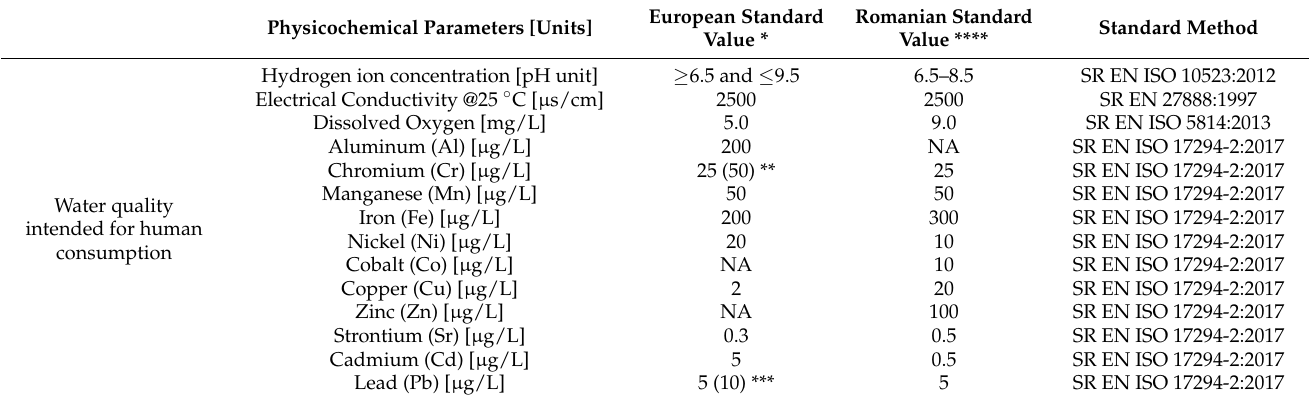
Table 2. Physicochemical parameters for water intended for human consumption provided by both European and Romanian legislations, and standard methods.